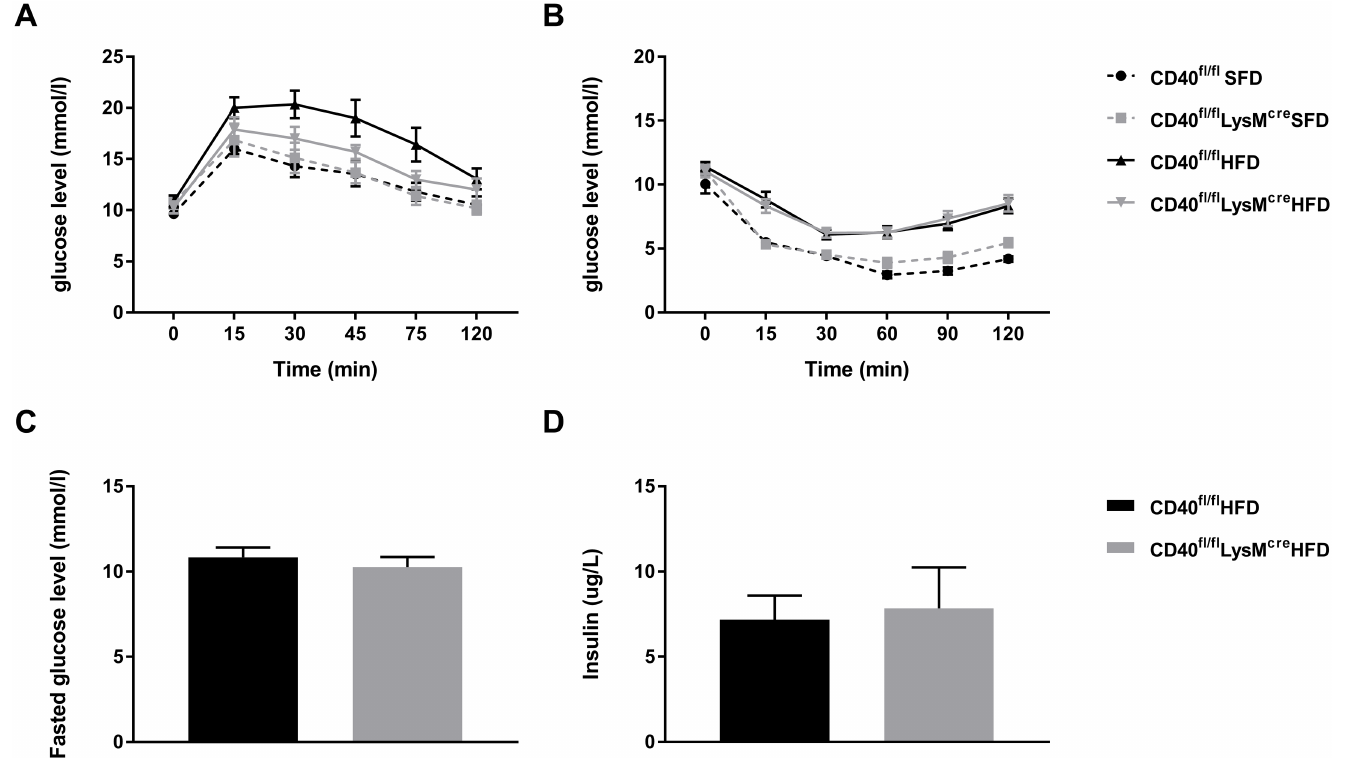
Fig 2. CD40 fl/fl LysM cre mice have similar glucose tolerance and insulin resistance than their WT controls. (A) Glucose tolerance test (n = 6–9 mice/group). (B) Insulin tolerance test (n = 6–16 mice/group). (C) Fasted glucose levels (n = 6–9 mice/group). (D) Fasted insulin levels (n = 5–8 mice/group). Data is presented as mean ±